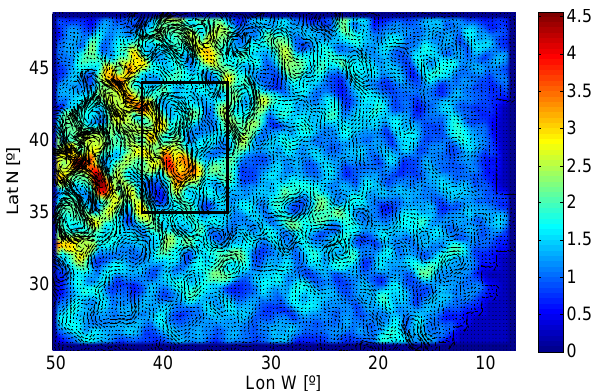
Fig. 6. Phytoplankton patch size B s × 10 − 5 km 2 after 30days de- pending on the position of the nutrient source in the stationary al- timetry flow. Especially in the black box (also marked in Fig. 1b) strong differences in patch size are obvious.